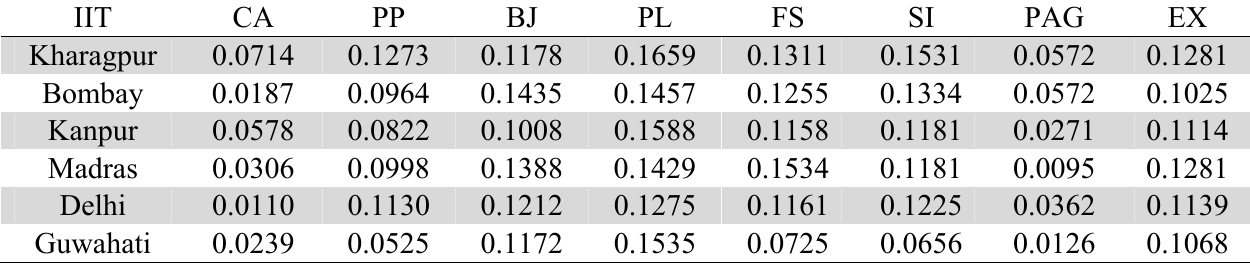
Weighted normalized decision matrix